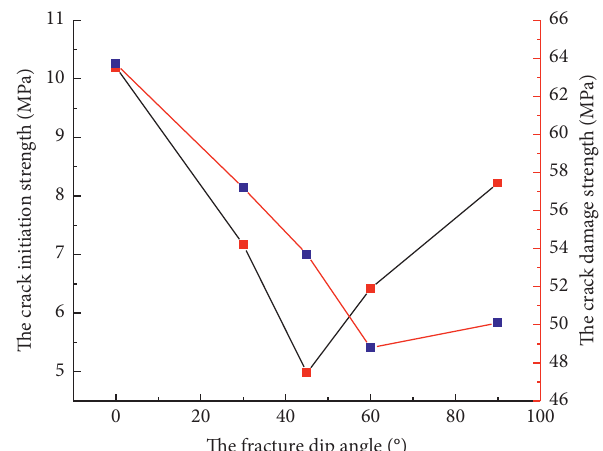
Figure 7: The strength eigenvalue under different fracture dip